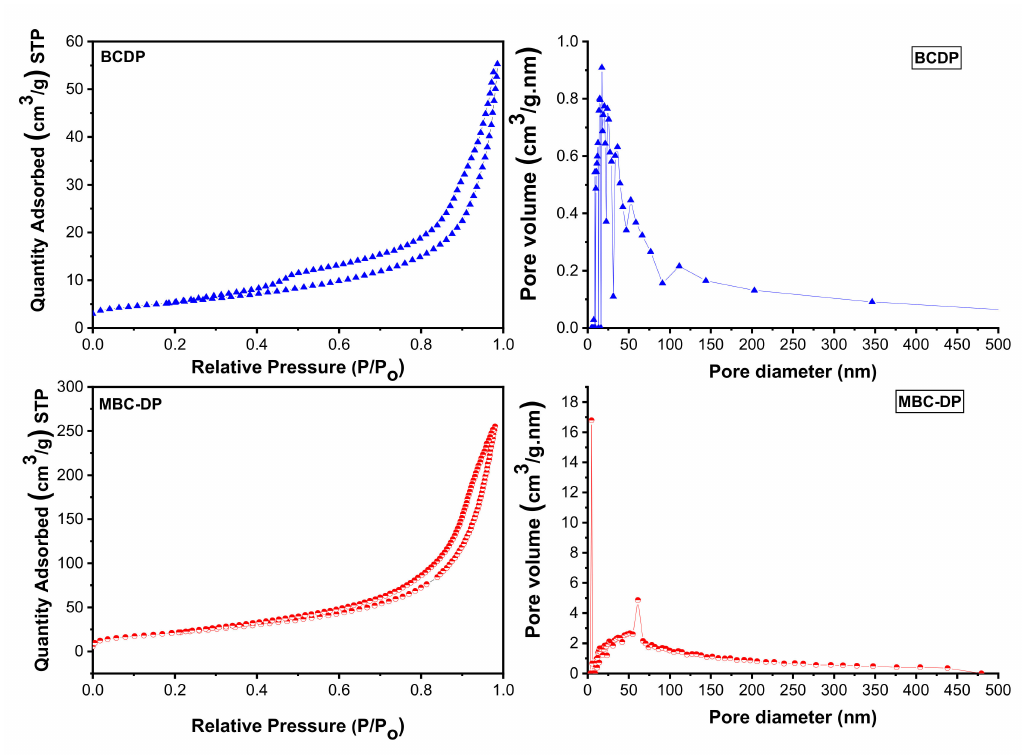
Figure 6. BET analysis of the as-prepared samples of BCDP and